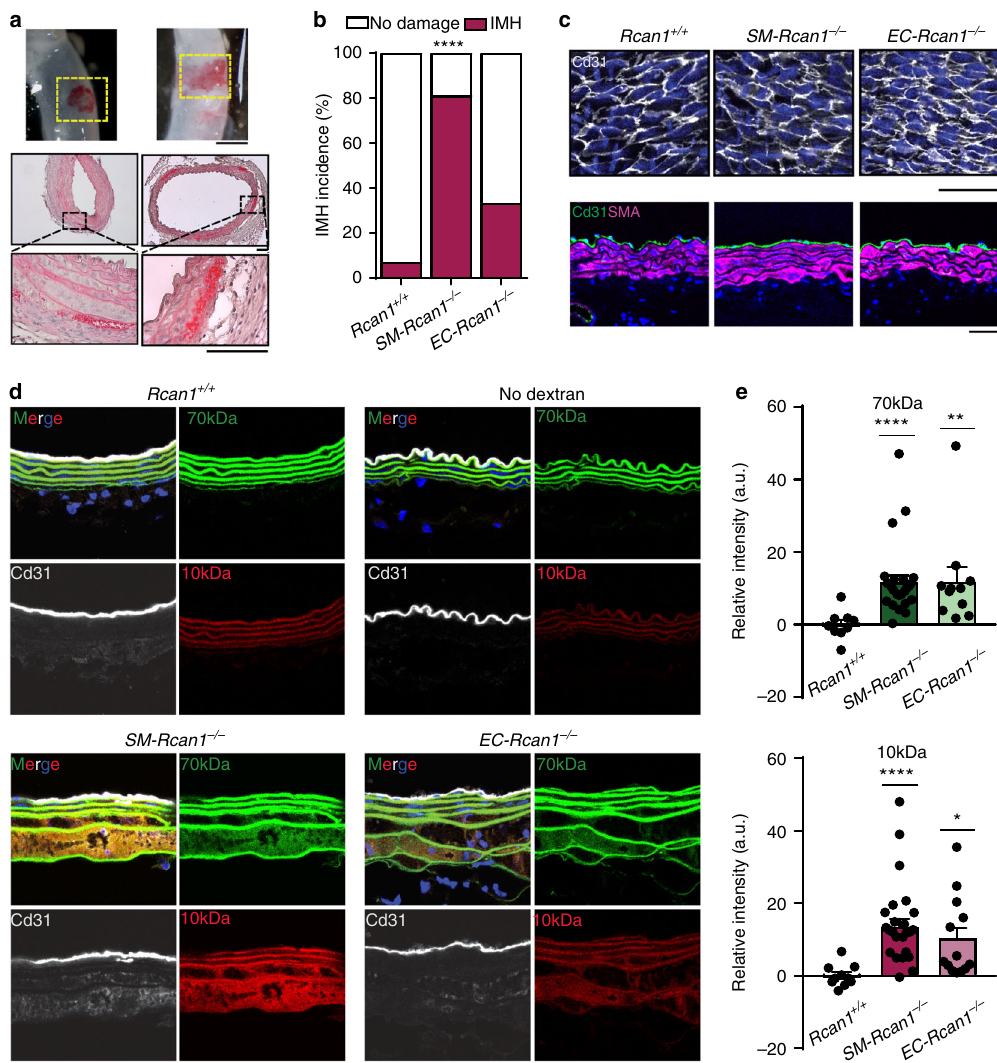
Fig. 5 Conditional Rcan1 − / − mice show increased aortic permeability. a (Top panels) Representative images of macroscopic incipient hematomas found after 6 h of AngII infusion (1 μ g kg − 1 min − 1 ). Scale bar, 1 mm. (Middle and bottom panels) Hematoxylin-eosin staining of these hematomas. Scale bars, 100 µ m. b Incidence of aortic IMH after 6 h of AngII infusion in Rcan1 + / + ( n = 14), SM-Rcan1 − / − ( n = 16), and EC-Rcan1 − / − mice ( n = 12). Chi-square distribution, **** p < 0.0001 vs. Rcan1 + / + . c Representative images of Cd31 immuno fl uorescence in en face (top panels) and transversal section (bottom panels) of aortas from mice infused for 6 h with AngII. Cd31 (gray, top panels; green, bottom panels), DAPI-stained nuclei (blue). Scale bar, 20 μ m. d Representative images showing the accumulation of FITC-labeled 70-kDa dextran (green) and RhodamineB-labeled 10-kDa dextran (red) in aortas of Rcan1 + / + ( n = 10), SM-Rcan1 − / − ( n = 16), and EC-Rcan1 − / − ( n = 12) mice infused for 6 h with AngII. Elastin auto fl uorescence is shown also in green. Aortas were also stained with anti-Cd31 (gray) and DAPI (blue). Scale bar, 50 µ m. e Fluorescence intensity quanti fi cation of the accumulation of (top) FITC-labeled 70-kDa dextran and (bottom) RhodamineB-labeled 10-kDa dextran in aortic sections from the same mice; a.u., arbitrary units. Each data point denotes an individual mouse, whereas histograms denote means + s.e.m. Kruskal-Wallis with Tukey Dunn multiple comparison post-hoc test, **** p